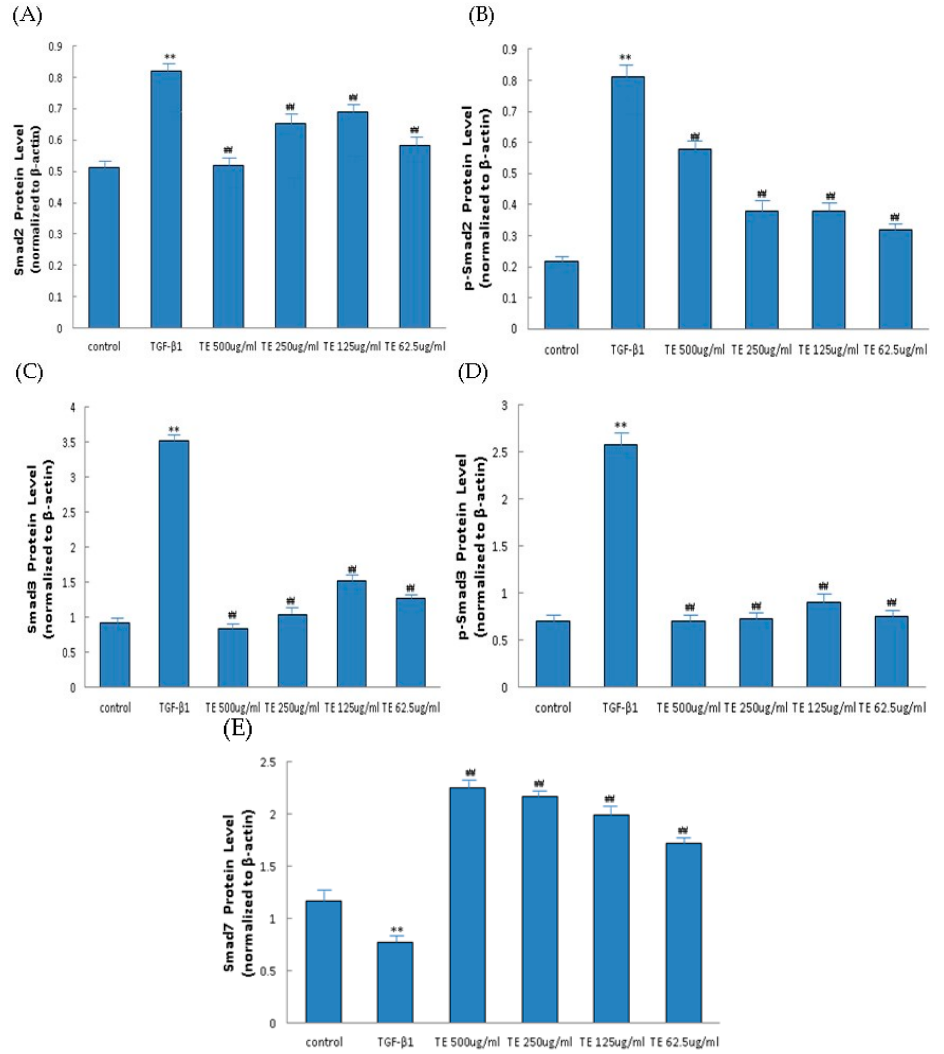
Figure 7. Effects of echinacoside on the protein expression of smad2, p-smad2, smad3, p-smad3 and smad7 in HSC. ( A ) Smad2 protein level; ( B ) P-smad2 protein level; ( C ) Smad3 protein level; ( D ) P-smad3 protein level; ( E ) Smad7 protein level. Data were expressed as mean ± SD. ** p < 0.01 compared with control group, ## p < 0.01 compared with TGF- β 1 group.